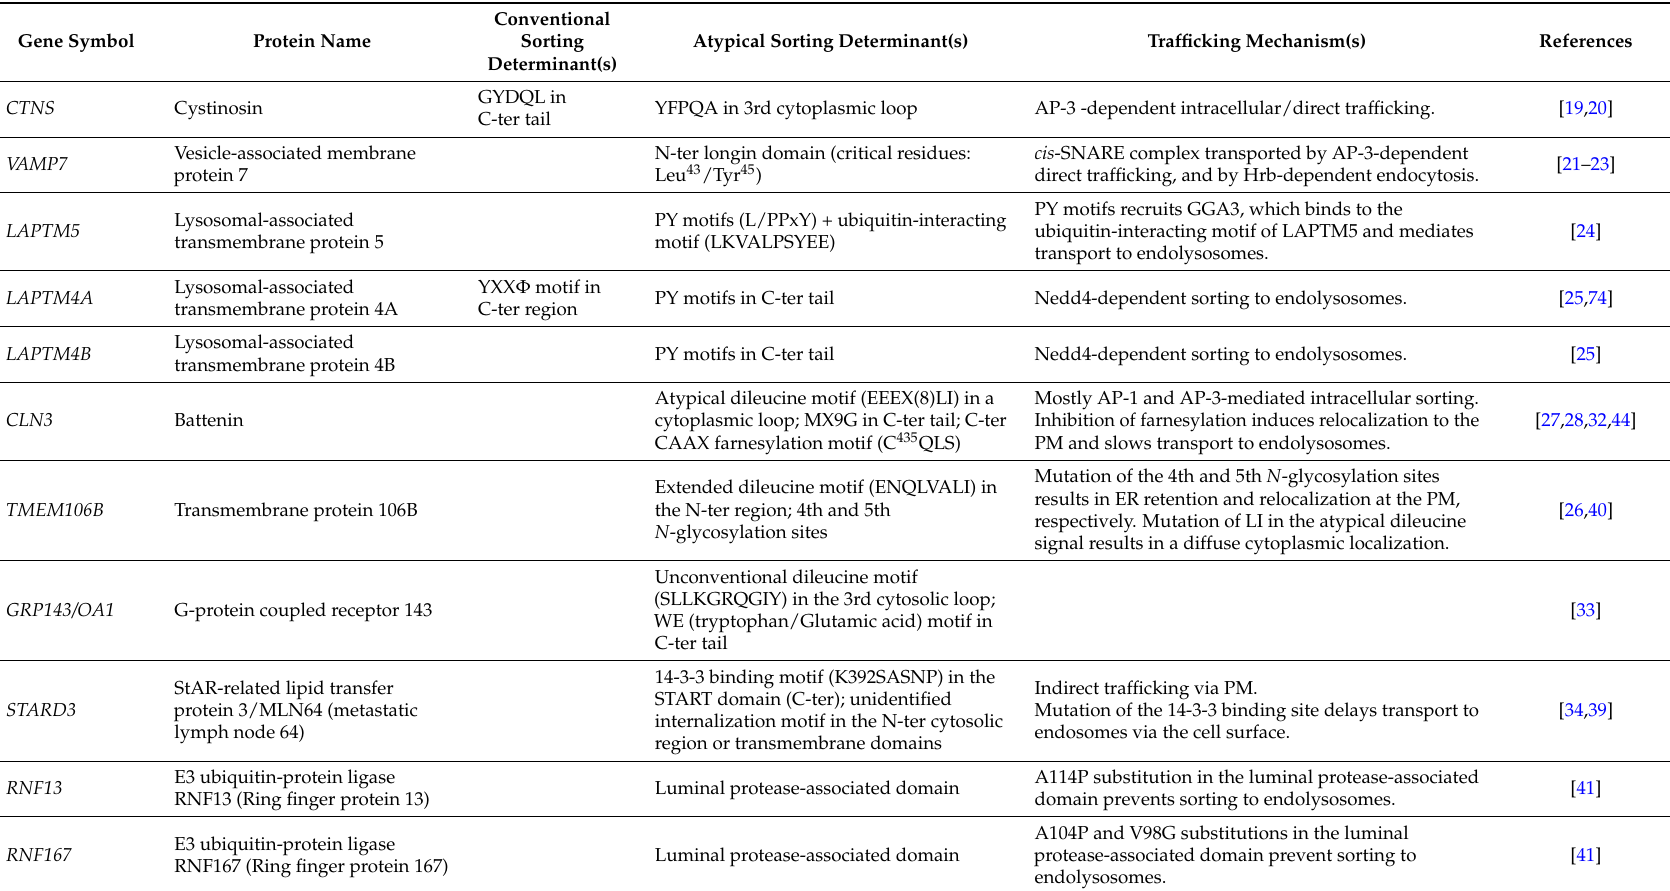
Table 1. Lysosomal transmembrane proteins with atypical sorting signals or transport routes to the